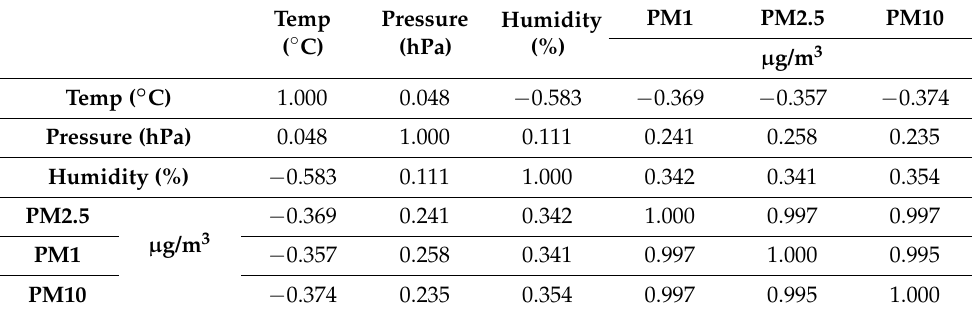
Table 2. Correlation coefficients for the measured parameters from Airly sensors for all data points.